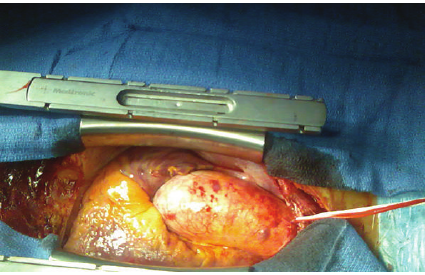
Figure 3: Intraoperative clinical image showing the pale blue aneurysm with very thin wall and features of localised imminent rupture